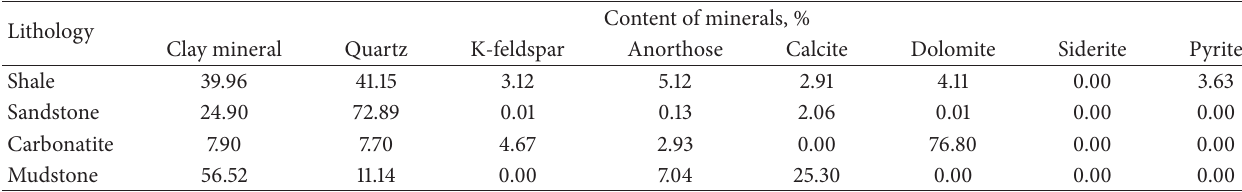
Table 2: Quantitative analyses of minerals by XRD.